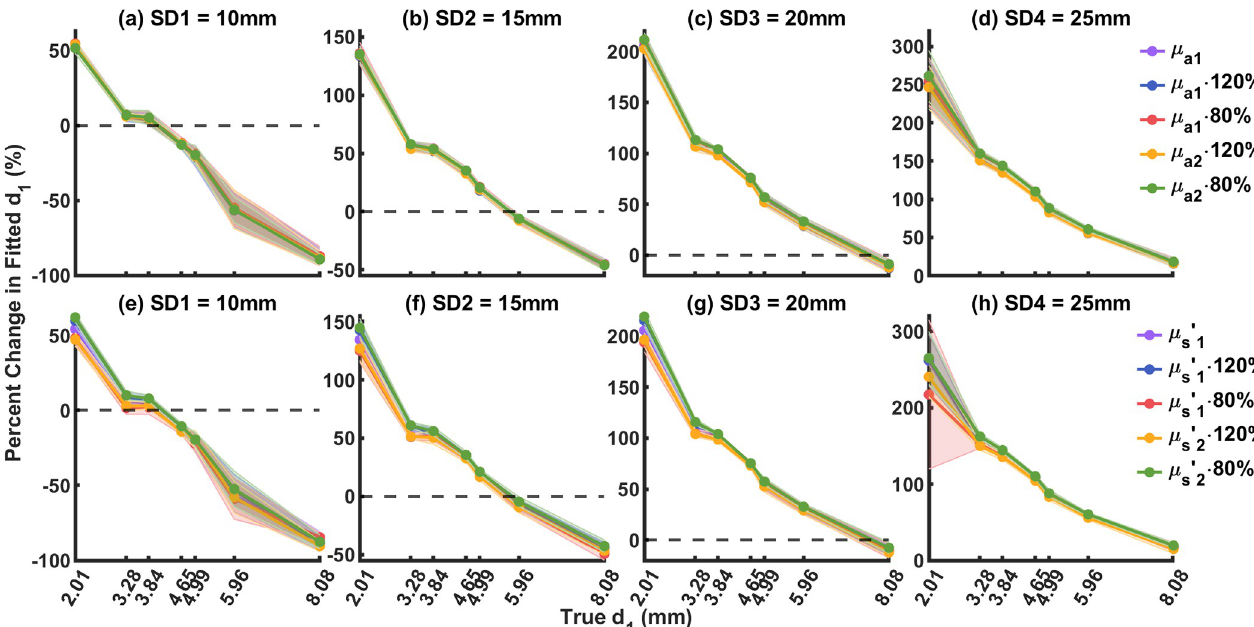
Fig 9. Influence of uncertainties in layer optical properties on fitted d 1 . Purple: baseline. Blue: first layer increased by 20%. Red: first layer decreased by 20%. Yellow: second layer increased by 20%. Green: second layer decreased by 20%. (a-d) Influence of layer μ